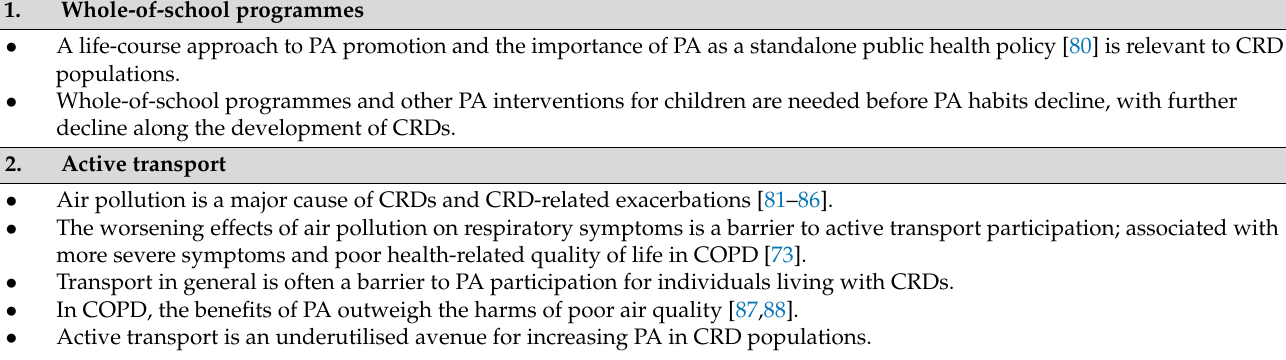
Table 1. Examples of the relevance of chronic respiratory disease for the International Society for Physical Activity and Health’s eight investments for physical